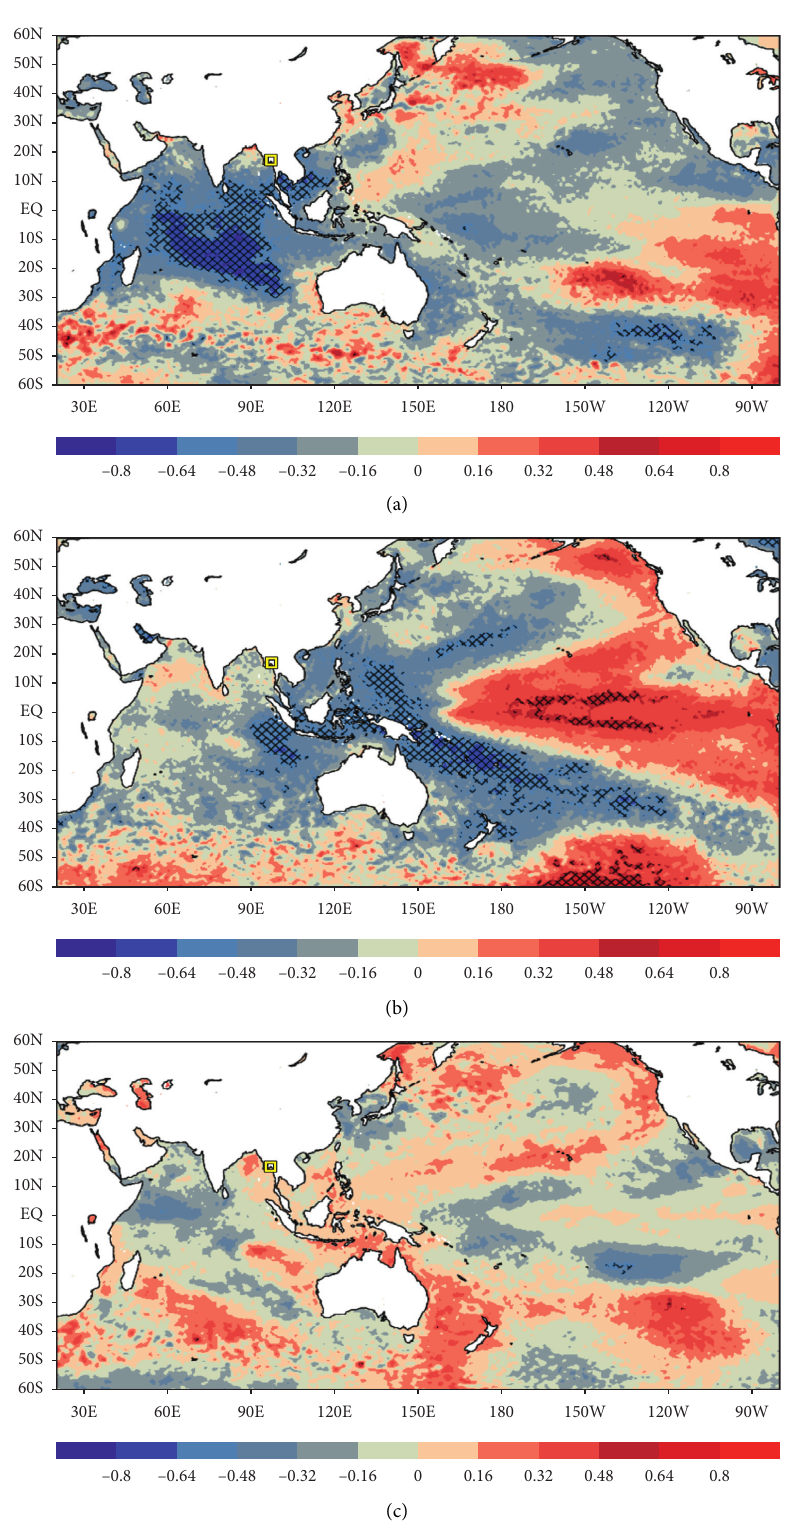
Figure 16: Correlation of SST with convective rainfall over the VYYY (shaded) and correlation significant area (hatched) for (a) annual, (b) summer (JJAS), and (c) winter (DJF) at 95% confidence